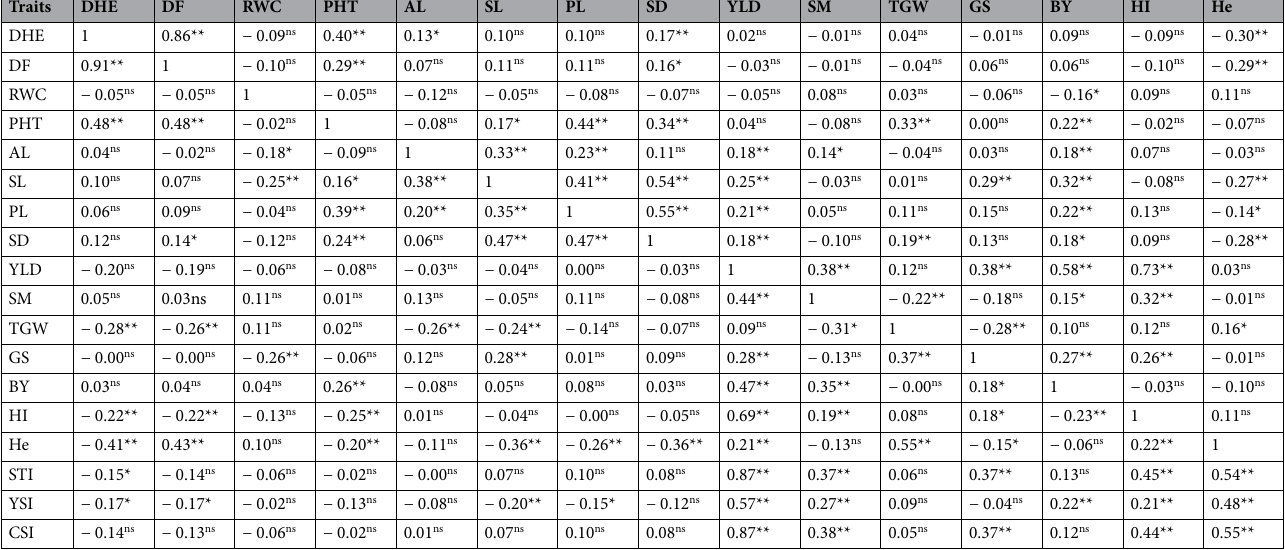
Table 3. Correlation coefficients among different traits, stress tolerance index (STI), yield stability index (YSI) and combination of significant indices (CSI) of synthetic hexaploid wheat derived lines evaluated under normal (above diagonal) and water-stressed (below diagonal) environments. DHE, days to heading; DF, days to flowering; RWC (%), relative water content; PHT (cm), plant height; AL (cm), awn length; SL (cm), spike length; PL (cm), peduncle length; SD, stem diameter (mm); YLD (g/m 2 ), grain yield; SM, spike per m 2 ; TGW (g), thousand-grain weight; GS, grains per spike; He, hectoliter (kg/he); BY (g/m 2 ), biological yield; HI (%), harvest index; STI, stress tolerance index; YSI, yield stability index; CSI, combination of significant indices. ns; * and **Non-significant, significant at 0.05 and 0.01 probability level,